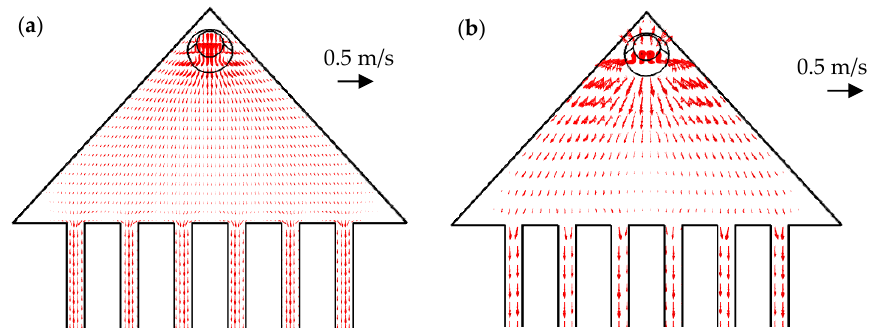
Figure 16. FDU study for the triangular shape. ( a ) Schematic view of the velocity profile for a 5 mL/min flow and at a scale of 20. ( b ) Schematic view of the speed profile for a 100 mL/min flow and at scale of 2.